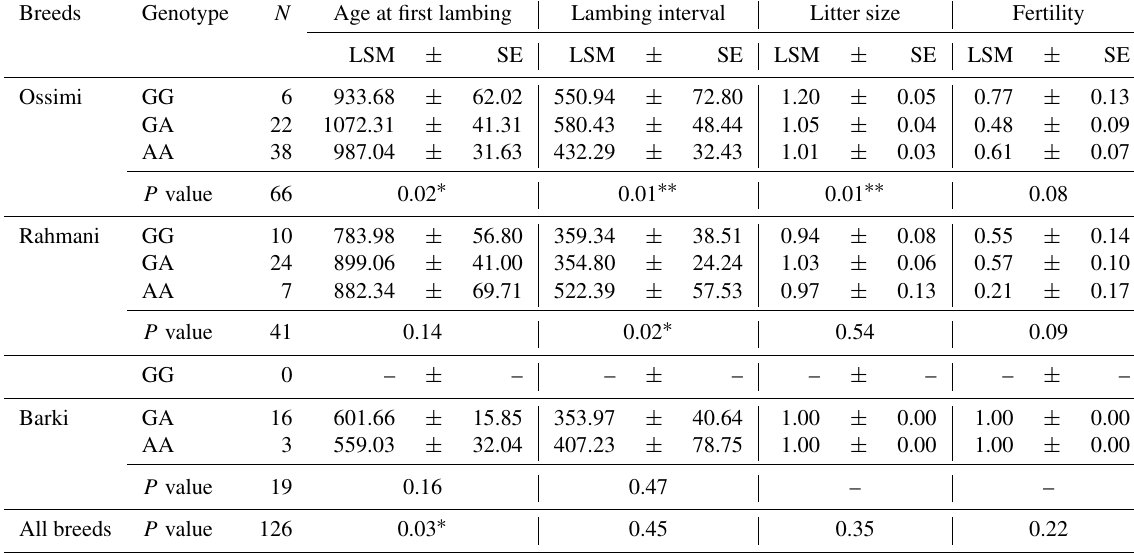
Table 5. Effect of the AA-NAT SNP on reproductive traits in Egyptian sheep breeds. Where N is the number of observed genotypes; LSM represents least-square mean; SE represents standard